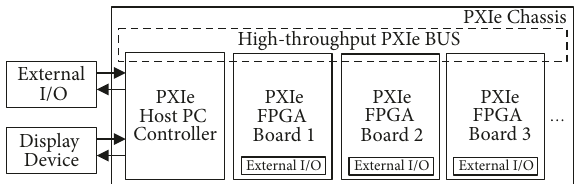
Figure 7: Block diagram of a PXIe-based multi-FPGA system with a host PC controller connected through a high-speed bus on a PXIe chassis